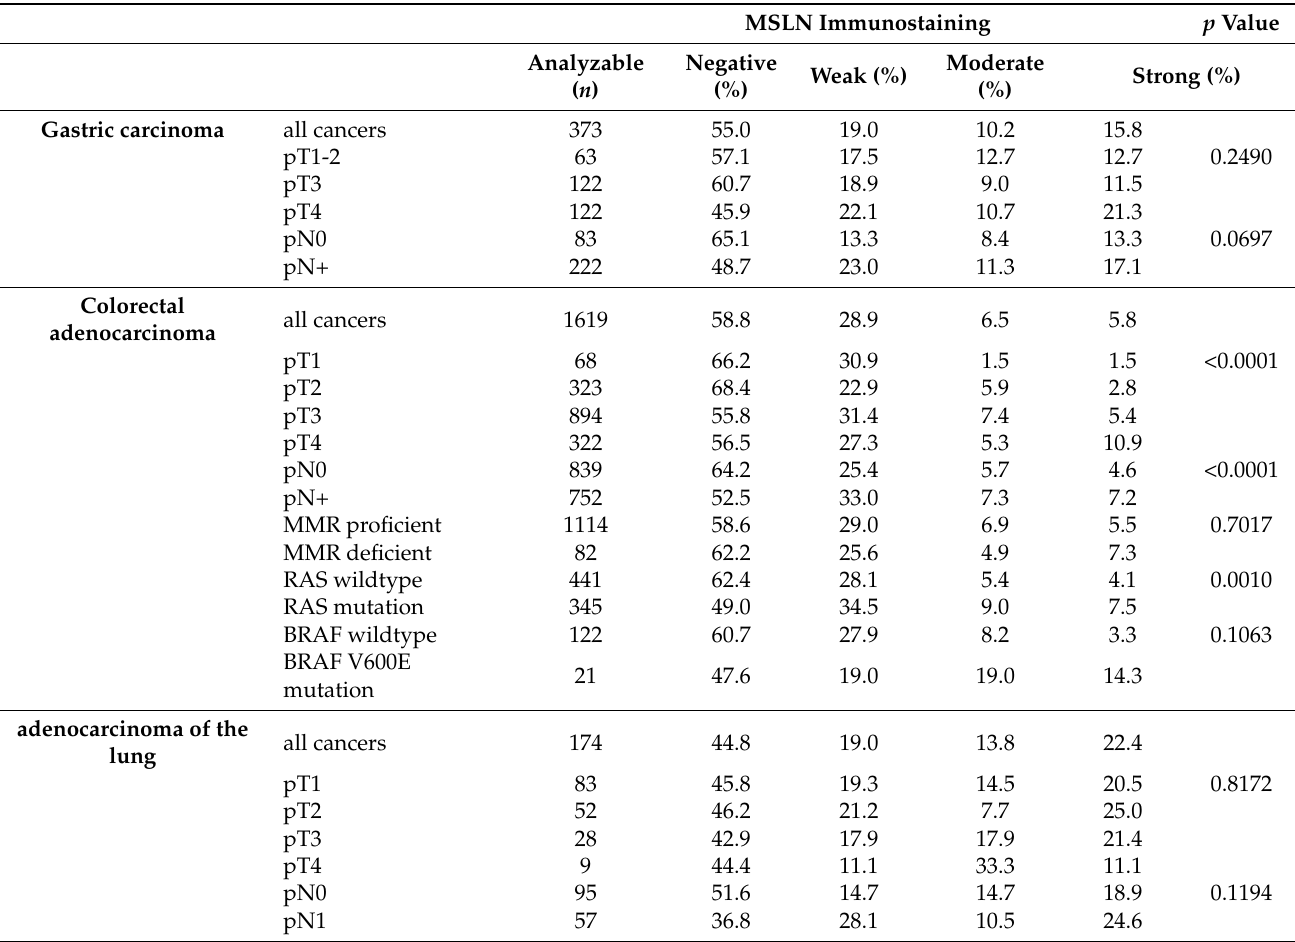
Figure 4. MSLN immunostaining and patient prognosis. All bladder cancer patients had at least pT2 cancers and were treated by cystectomy. Table 3. MSLN immunostaining and HPV status. MSLN Immunostaining